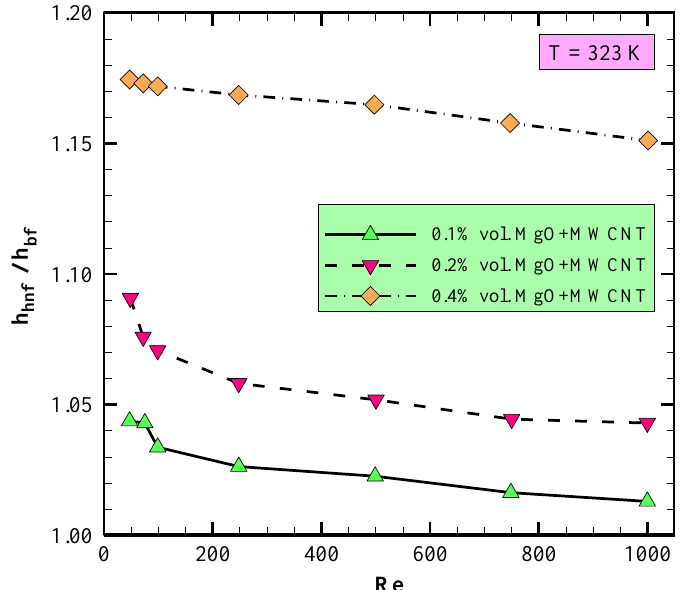
Figure 9. Influence of using HNF with different volume fractions on HT coefficient for various Re and inlet temperature T = 323 K.